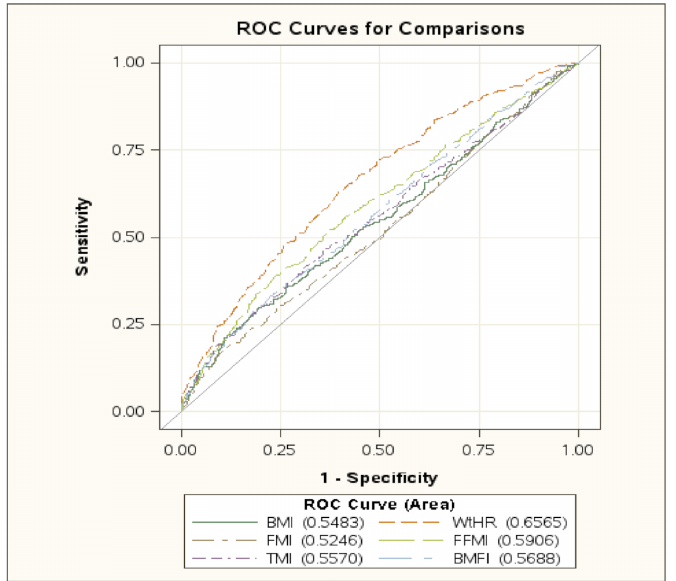
Figure 2. The ROC curves of the different indices in the whole population. Area under the curve for the single index is reported in brackets. Abbreviations: BMI: body mass index; WtHR: waist-to-height ratio; FMI: fat mass index; FFMI: fat-free mass index; TMI: tri-ponderal mass index; BMFI: body mass fat index.